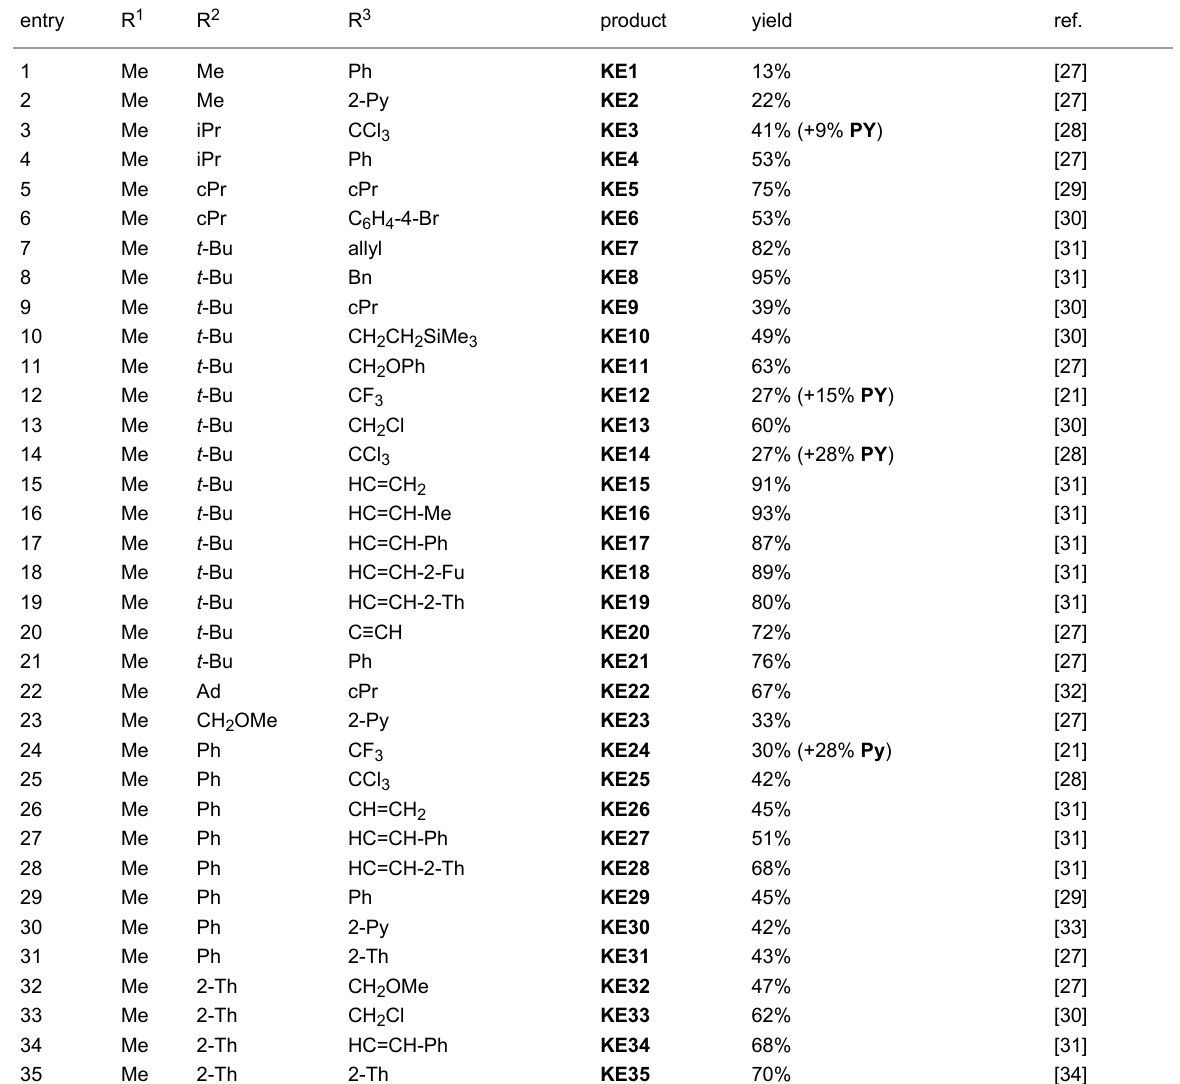
Table 1: Synthesis of β -ketoenamides KE1 – 35 through the LANCA three-component reaction of lithiated methoxyallene, nitriles (R 2 -CN) and carboxylic acids (R 3 -CO 2 H) according to Scheme 4. a entry R 1